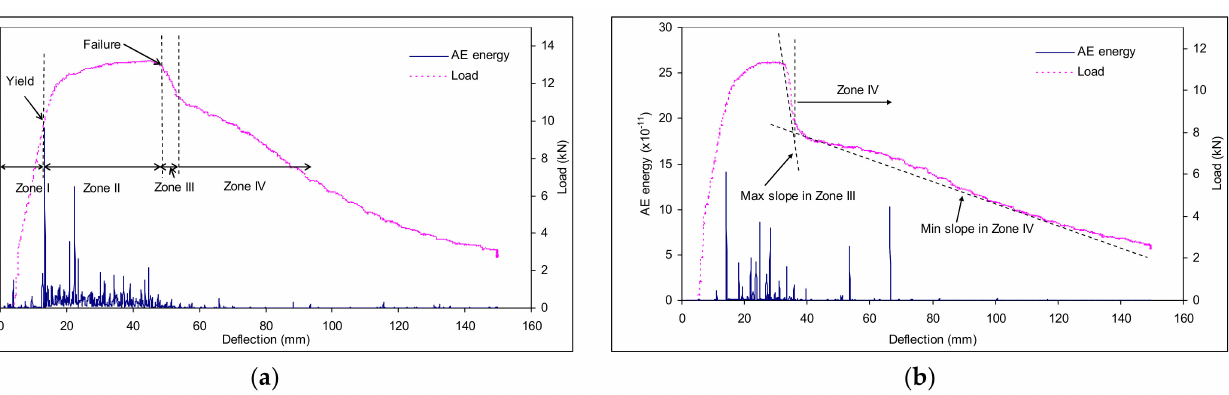
Figure 6. Normalised frequency for pipe 2 at deflection of 3.22 mm.